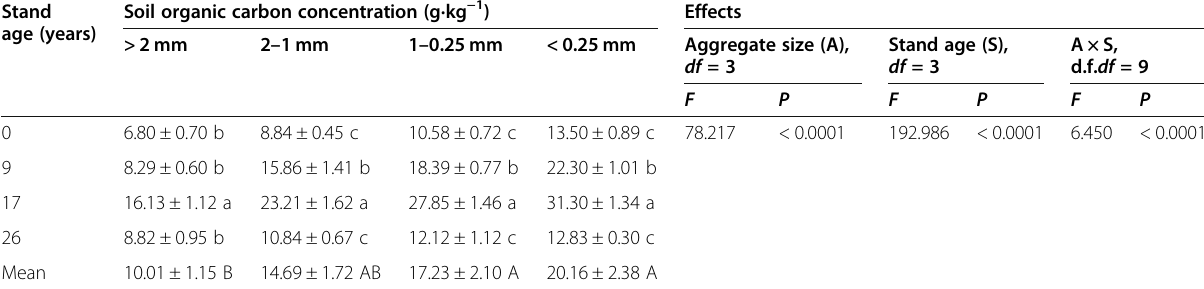
Data represent the average of 3 replicates ± standard errors. Different lowercase letters indicate significant differences among the different stand ages. Different capital letters indicate significant differences among the different aggregate